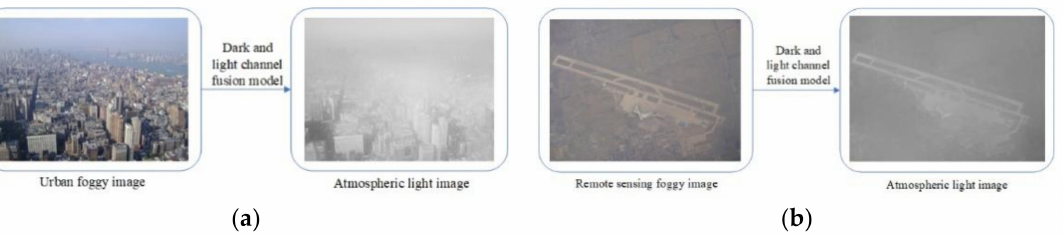
Figure 5. Foggy image and its atmospheric light map ( a ) Image of a foggy coastal city; ( b ) Satellite remote sensing